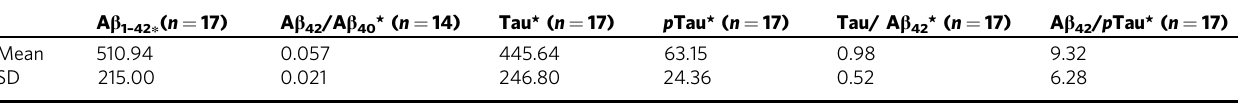
Table 2 CFS ’ s parameters of AD patients.